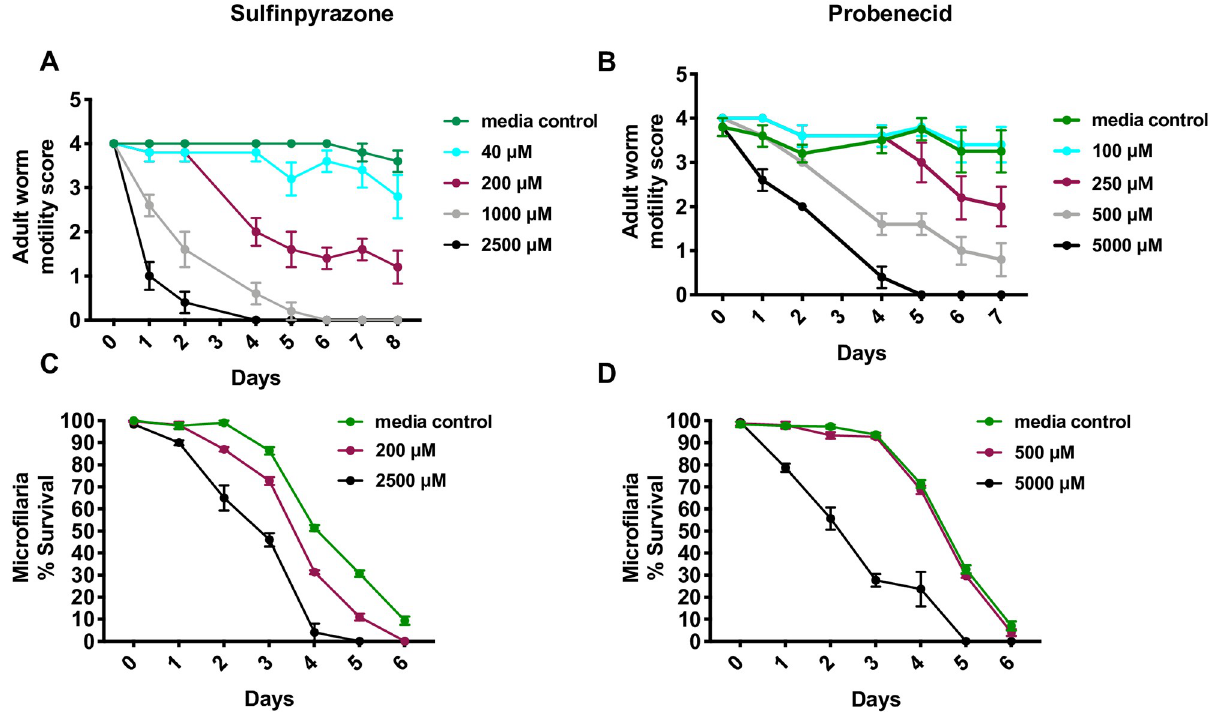
Fig 6. UGT inhibitors exhibit macrofilaricidal activity in vitro . Motility scores of adult B . malayi adult worms after incubation with various concentrations of (A) sulfinpyrazone (n = 5 for each group; 2500 μ M, p < 0.0001; 1000 μ M, p < 0.0001; 200 μ M, p < 0.0001; 100 μ M, ns) and (B) probenecid (n = 5 for each group; 5000 μ M, p < 0.0001; 500 μ M, p = 0.0004; 250 μ M, ns; 40 μ M, ns). For (A) and (B), the area under the curve (AUC) was calculated using the PRISM 7.0 software. Using these AUC values, a two-way ANOVA was performed to determine significance followed by Tukey’s multiple comparison test. Percent survival of B . malayi microfilariae incubated with (C) sulfinpyrazone (2500 μ M, p < 0.0001; 200 μ M, p = 0.0005) and (D) probenecid (5000 μ M, p < 0.0001; 500 μ M, ns). Percent survival was calculated from the first 100 Mf observed. The generated AUC values were analyzed using an ordinary one-way ANOVA to determine significance followed by Tukey’s multiple comparison test. These experiments were successfully repeated twice.